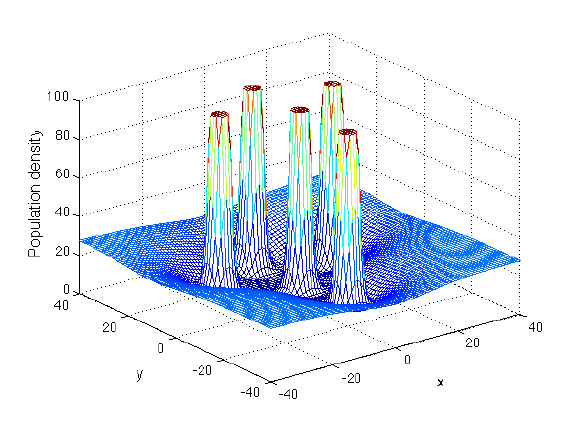
Fig. 4. Interference between the traps using setting (D). Zoom in of Fig. 3.